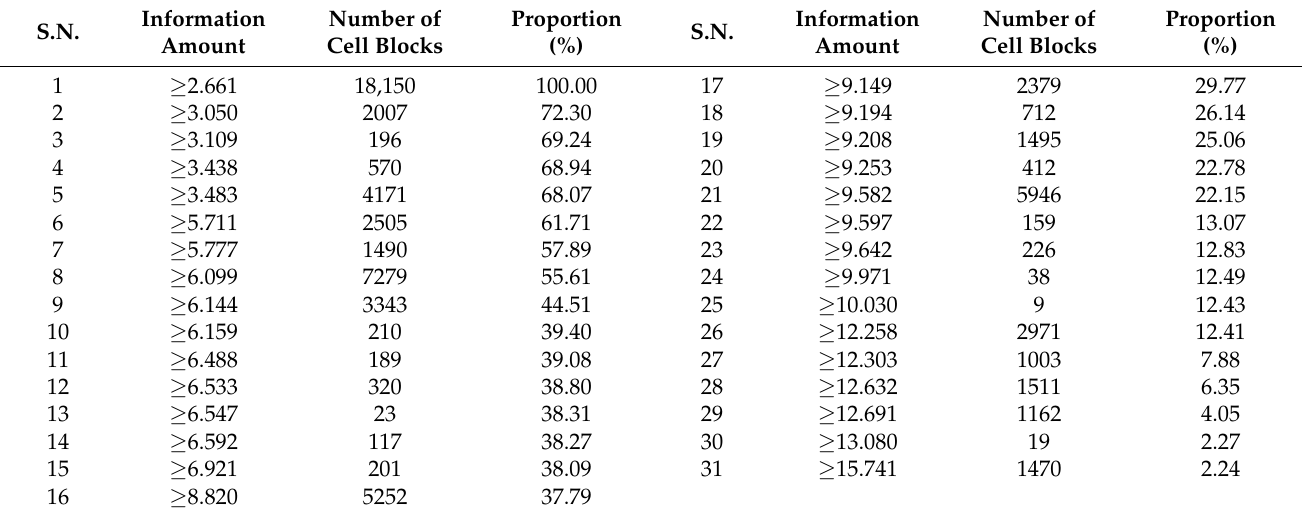
Table 5. Proportion of metallogenic information amount intervals of cell blocks of the Sanshandao